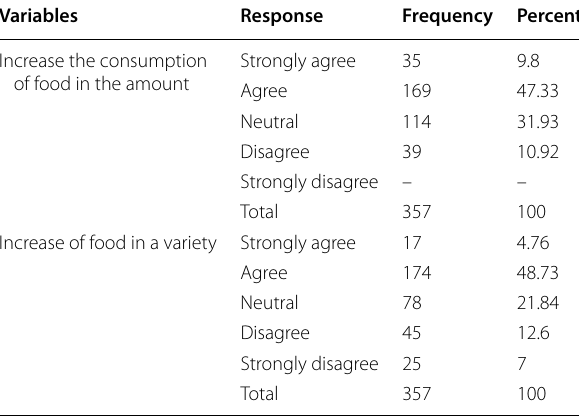
Table 5 Nutritional improvements of the respondents after the program intervention. Source : Author’s